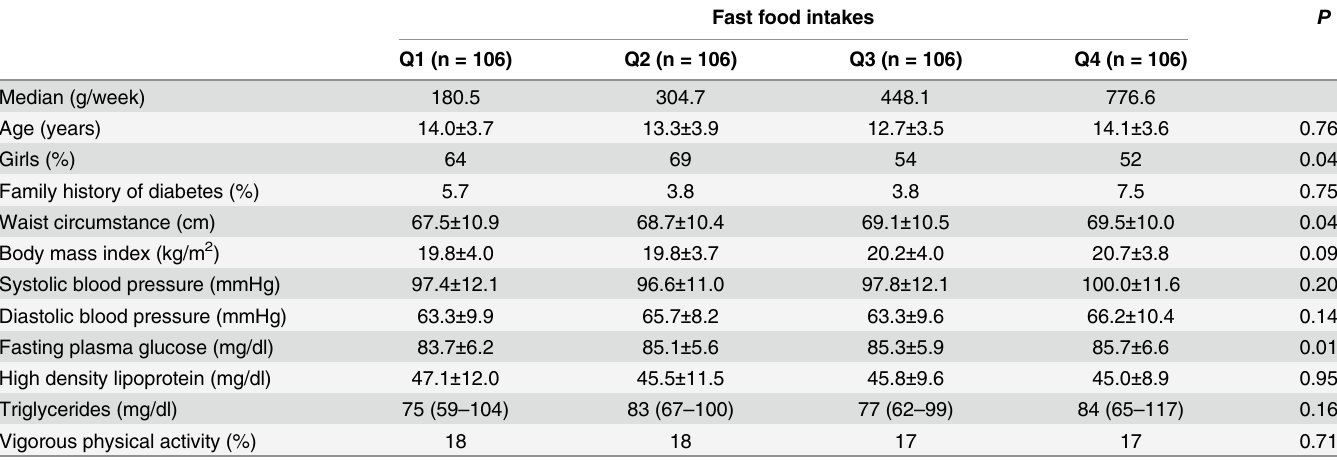
Table 1. Baseline characteristics of participants according to quartiles of fast food